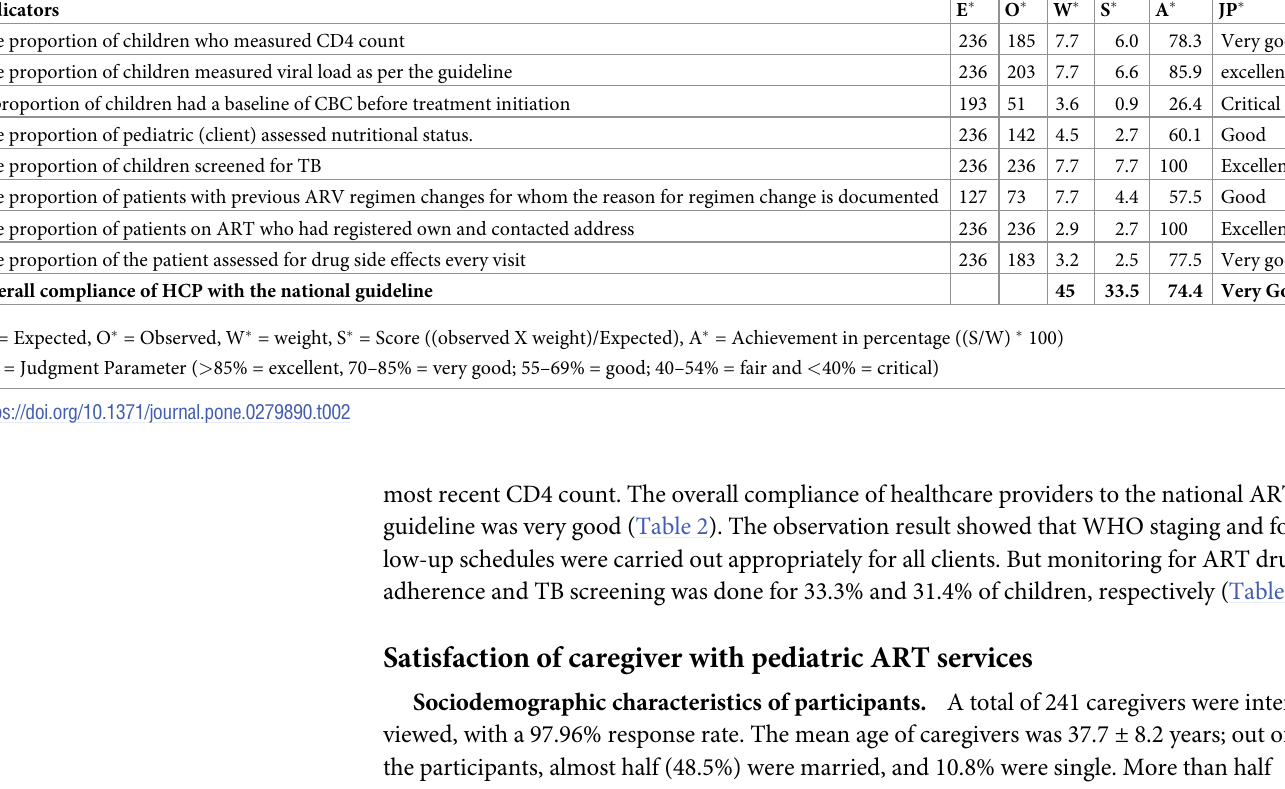
Table 2. Summary of compliance sub-dimensions indicators in GCAHCs, April 2020. Indicators